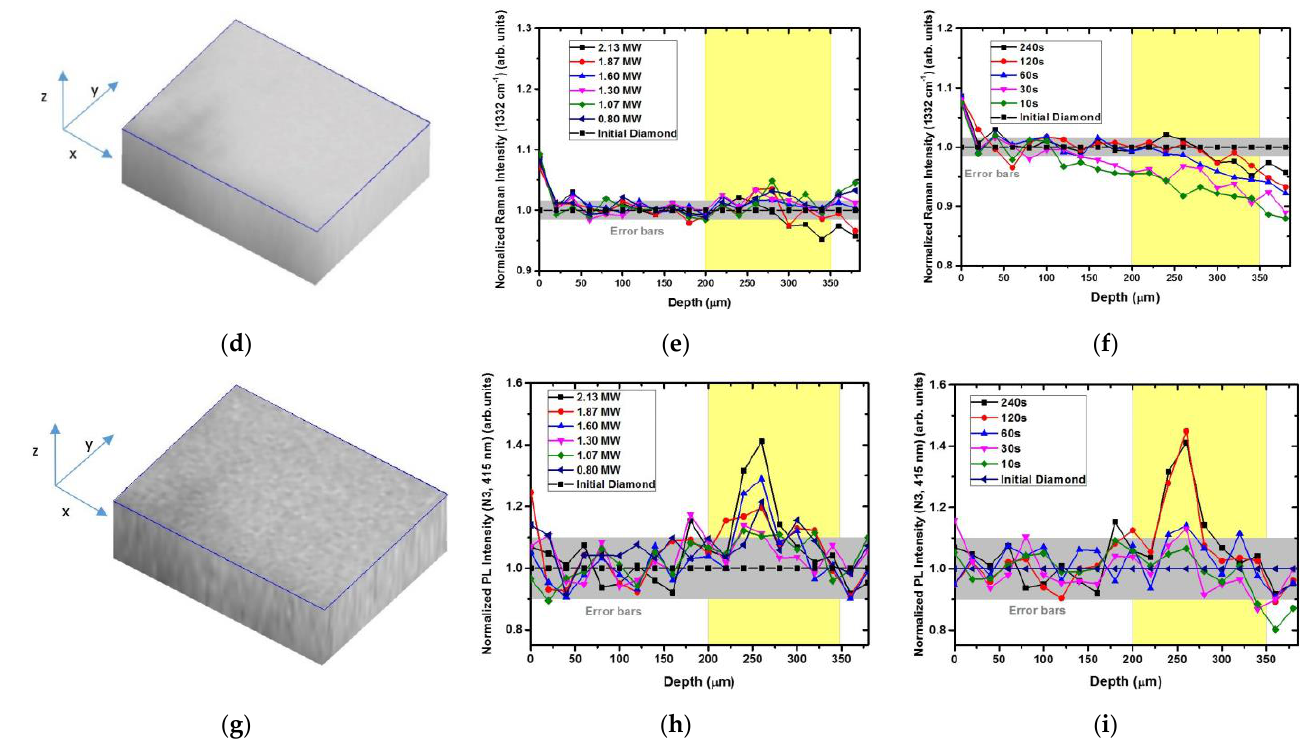
Figure 3. ( a ) The 3D PL map of the inscribed region with micromarks at the 550 nm wavelength. ( b ) Depth profiles of the micromarks inscribed at different peak powers and 240 s exposure time (24 × 10 6 pulses). ( c ) Depth profiles of the micromarks inscribed at different exposure times and 2.1 MW peak power (fluence — 5.5 J/cm 2 , intensity — 18 TW/cm 2 ). ( d ) The 3D Raman map of the inscribed region with micromarks at the 428 nm wavelength. ( e ) Depth profiles of the micromarks inscribed at different peak powers and 240 s exposure time. ( f ) Depth profiles of the micromarks inscribed at different exposure times and 2.1 MW peak power. ( g ) The 3D map of the inscribed region with micromarks at the 415 nm wavelength. ( h ) Depth profiles of the micromarks inscribed at different peak powers and 240 s exposure time. ( i ) Depth profiles of the micromarks inscribed at different exposure times and 2.1 MW peak power.